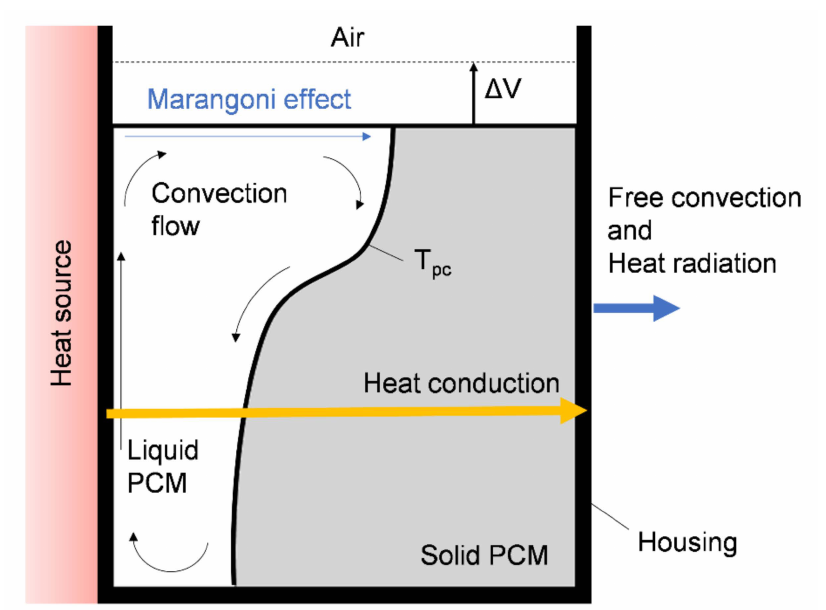
Figure 1. Schematic illustration of the physical effects of a melting PCM with a heat source at the left